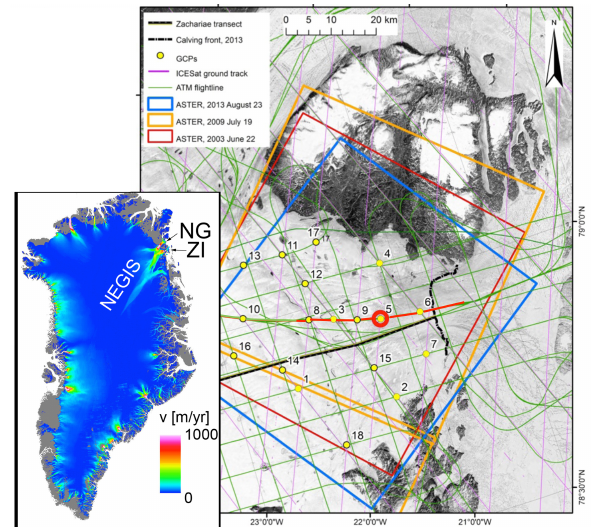
Figure 5. Location map of data combined for elevation change reconstruction. Elevation data set includes ICESat (purple lines) and ATM (green lines) altimetry and ASTER DEMs (a total of 10; June 21, 2001 (red box); July 19, 2009 (orange box) and August 23, 2013 (blue box) are shown). Small yellow circles mark surface patches used for DEM correction. Elevation change time series for site 5 (large red circle) are presented in Fig. 4. Central flow line profile, shown Fig. 9, is marked by red line. Thick black line is 2013 calving front. Small map shows location of Zachariæ Isstrøm (ZI) on ice velocity map from Rignot and Mouginot (2012).